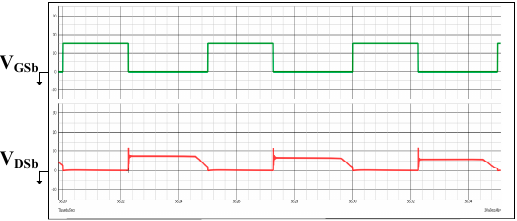
Figure 19. Simulation of voltage waveforms of S b (V GSb , V DSb ), V GSb , V DSb : 10 V/div, Time: 20 µs/div.